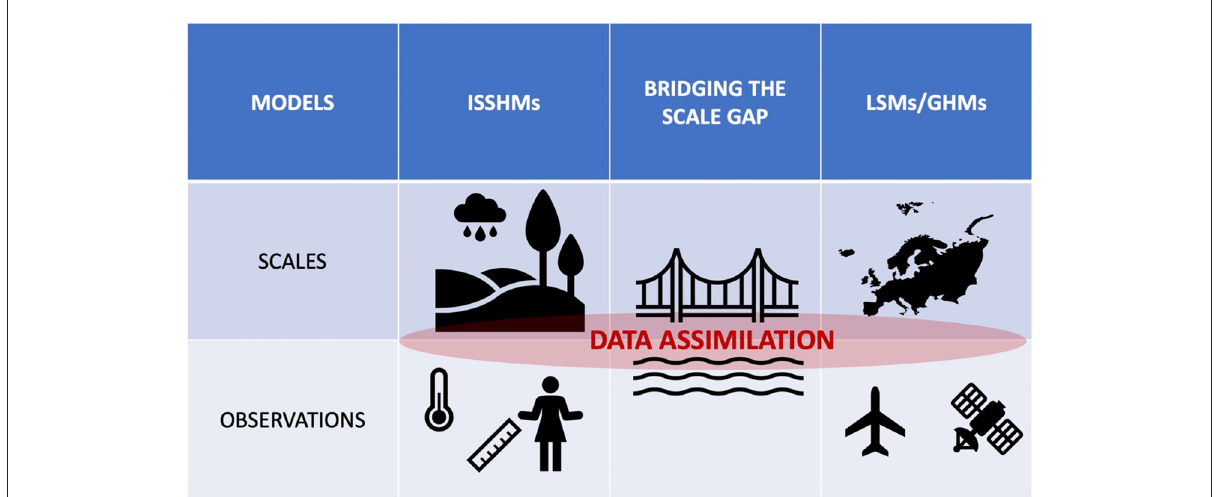
FIGURE1 Data assimilation combines the strengths of modeled and observed hydrological estimates. Integrated surface-subsurface hydrological models (ISSHMs) typically operate within spatial scales ranging from hillslope to local-scale or meso-scale catchments and its data assimilation techniques primarily incorporate local ground-based observations. Land Surface (LSMs) and Global Hydrological models (GHMs) operate within continental and global spatial scales and their data assimilation applications utilize remotely sensed observations. This mini review discusses possible new directions for data assimilation technologies which could potentially bridge the scale gaps between the ISSHM and LSM/GHM scientific